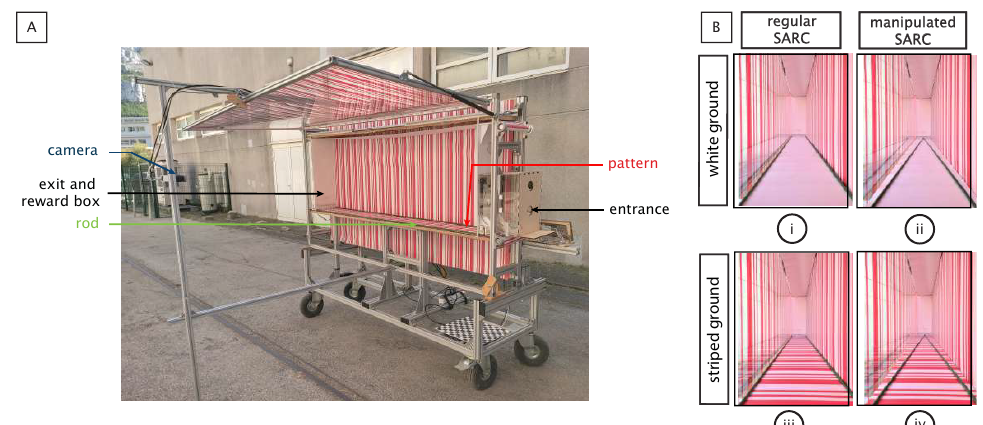
Figure 3. Internal and external views of the flight tunnel. ( A ) Flight tunnel designed to manipulate both SARC and OSRC. Textures on the ground could provide easy or reduced access to OSRC. Two motorized green rods allowed manipulation of either SARC or splay angle during or between the bees’ flights. Speed, acceleration, and amplitude of SARC could be tuned. ( B ) Optical invariants provided inside the tunnel. In ( Bi , Bii ) a uniform white sheet provided weak access to OSRC. In ( Biii , Biv ), a striped pattern provided easy access to OSRC. In ( Bi ), splay angle was not manipulated, whereas in ( Bii ), the rods were converging. SARC is positive from ( Bi ) to ( Bii ) and negative from ( Bii ) to ( Bi ). Adapted from